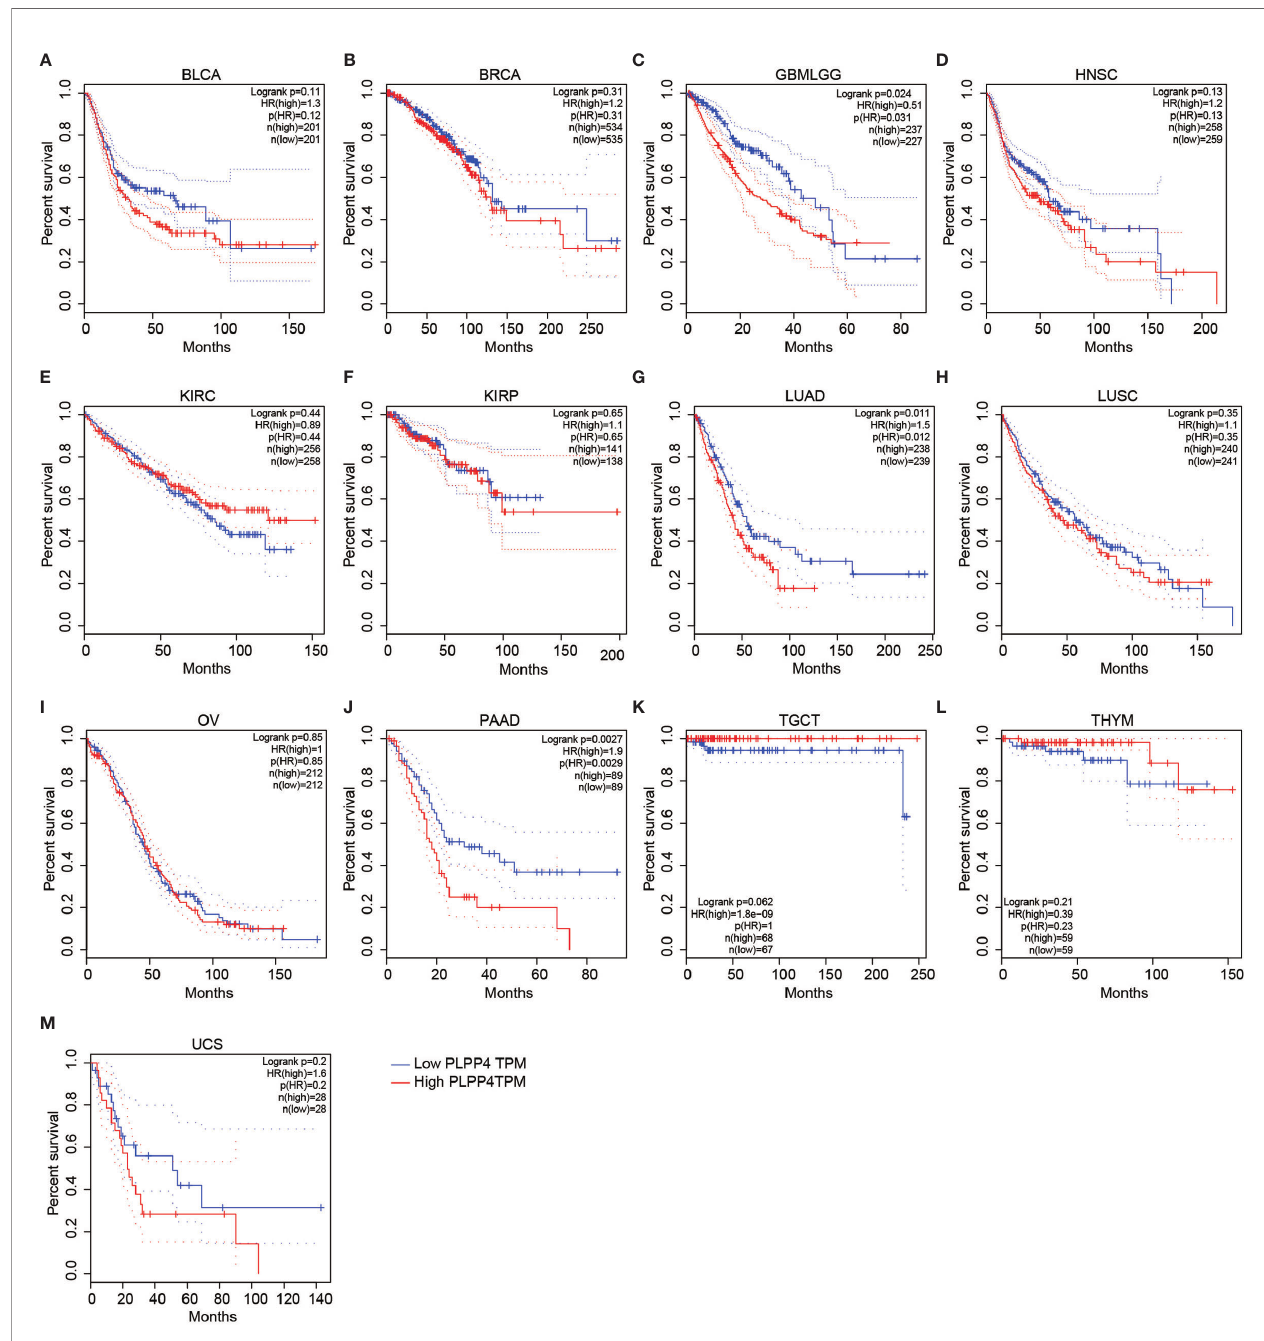
FIGURE 4 | Overall survival curves for the expression of PLPP4 in cancers (Kaplan – Meier Plotter). High expression level of PLPP4 indicated shorter overall survival in glioma, LUAD, and PAAD cases. (A – D) Survival curves for the expression of PLPP4 in BLCA, BRCA, GBMLGG and HNSC. (E – H) Survival curves for the expression of PLPP4 in KIRC, KIRP, LUAD and LUSC. (I – L) Survival curves for the expression of PLPP4 in OV, PAAD, TGCT, and THYM. (M) Survival curves for the expression of PLPP4 in